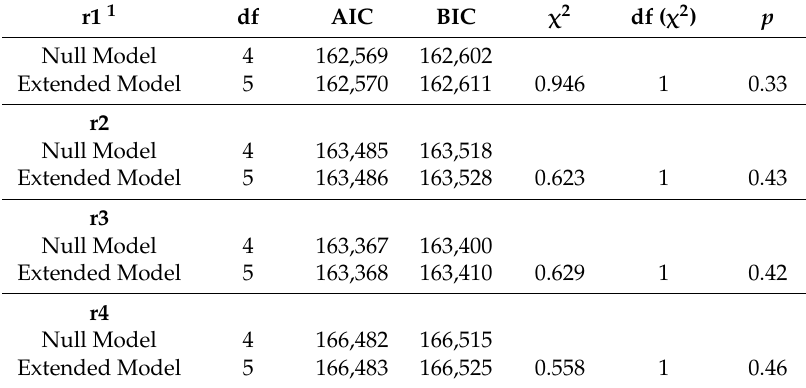
Table A4. Likelihood ratio tests for the null and extended models applied to free parameters in covariance matrix R